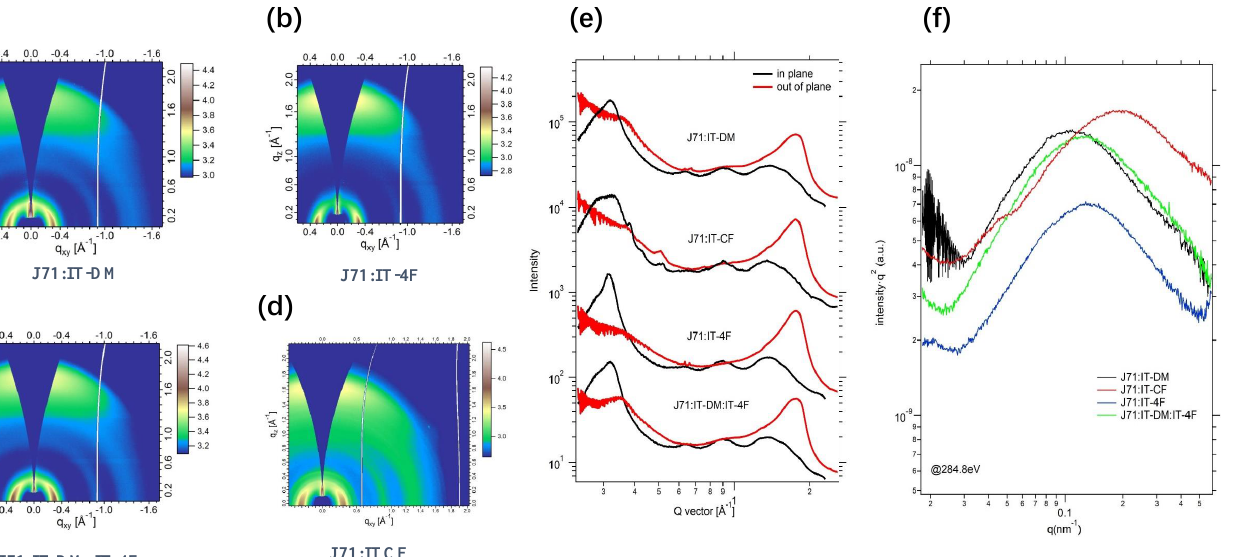
Figure 4. The GIWAXS 2D Patterns of the Active Blend Films of J71:IT-DM ( a ), J71:IT-4F ( b ), J71:IT- DM/IT-4F ( c ), and J71:ITCF ( d , e ) In-plane (IP) and Out-of-plane (OOP) GIWAXS Line-cut Profiles of Active Blend Films; ( f ) Soft X-ray Scattering of Active Blend